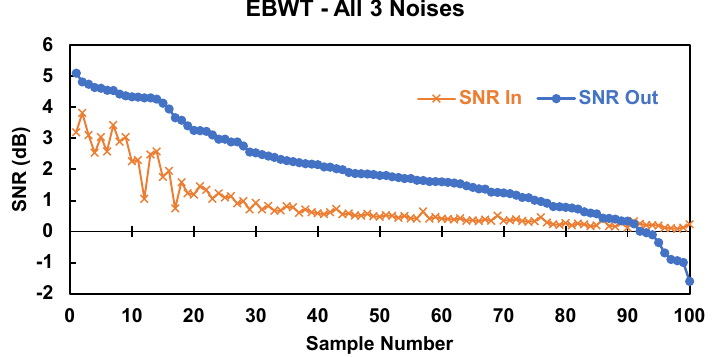
Figure 29. SNR of 100 samples of PD signals contaminated with the 3 types of noises simultane- ously denoised using MODWT. The maximum ∆ SNR = 6.37 dB, the minimum = 0.18 dB, and the average = 2.66 dB.